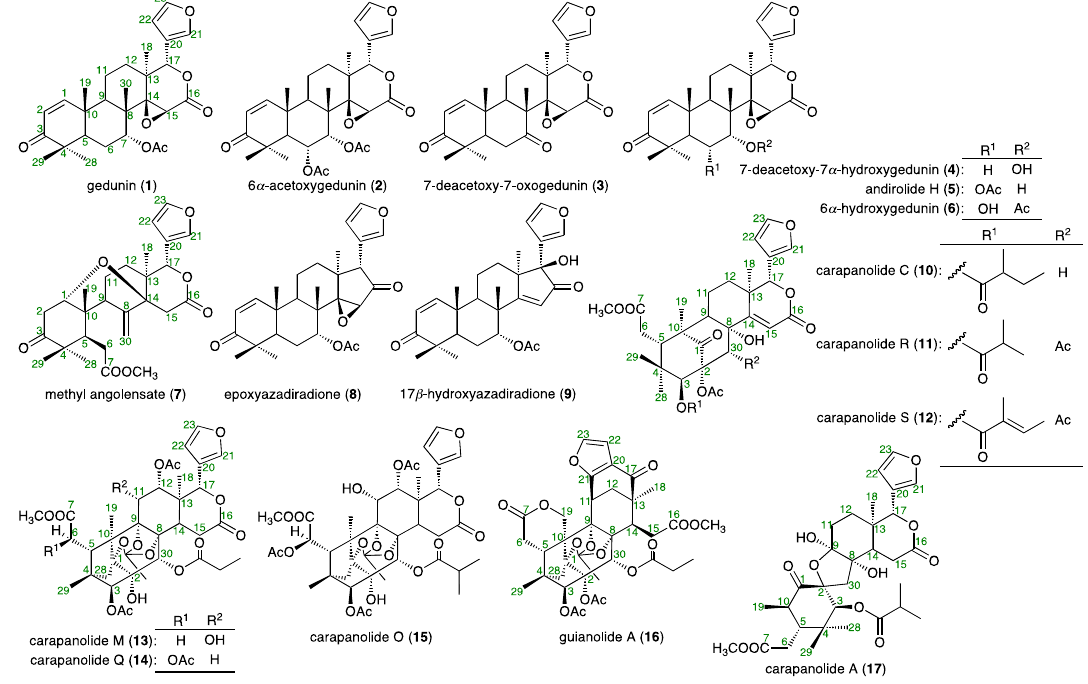
Figure 1. Limonoids ( 1 – 17 ) from seed and flower oils of C. guianensis .